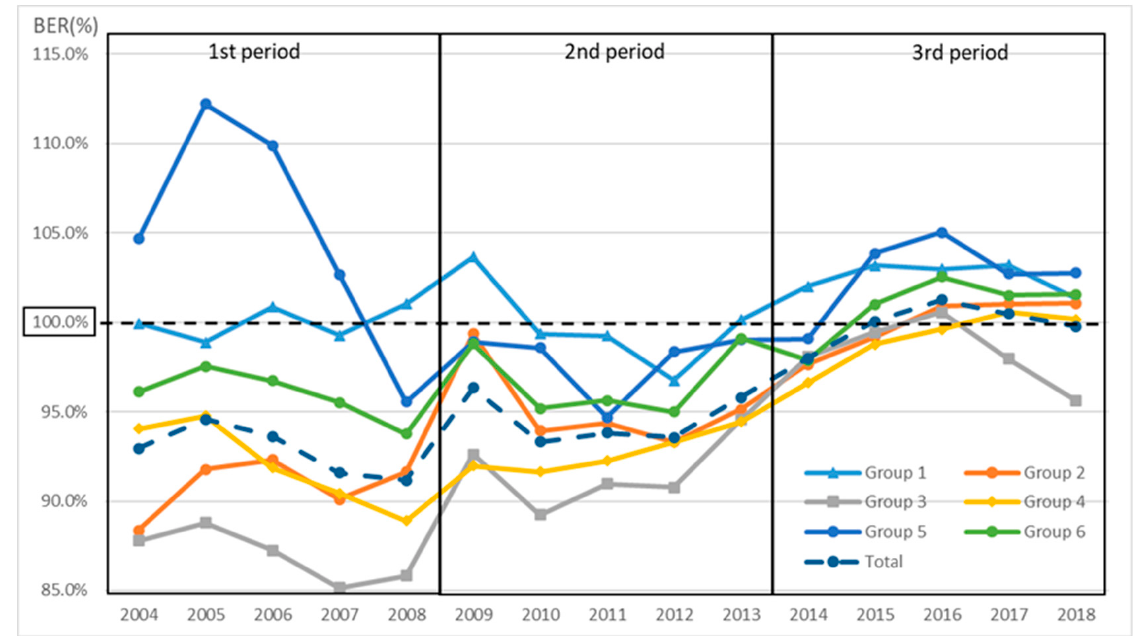
Figure 7. Calculation of BER (%) for each group. BER (%) above 100% means a deficit and a BER (%) below 100% means a surplus; in 2017 and 2018, all but group 3 were in deficit.